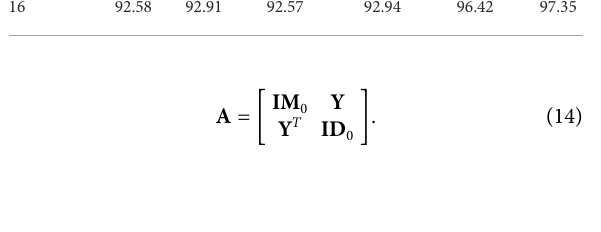
FIGURE 2 AUPR of models with different